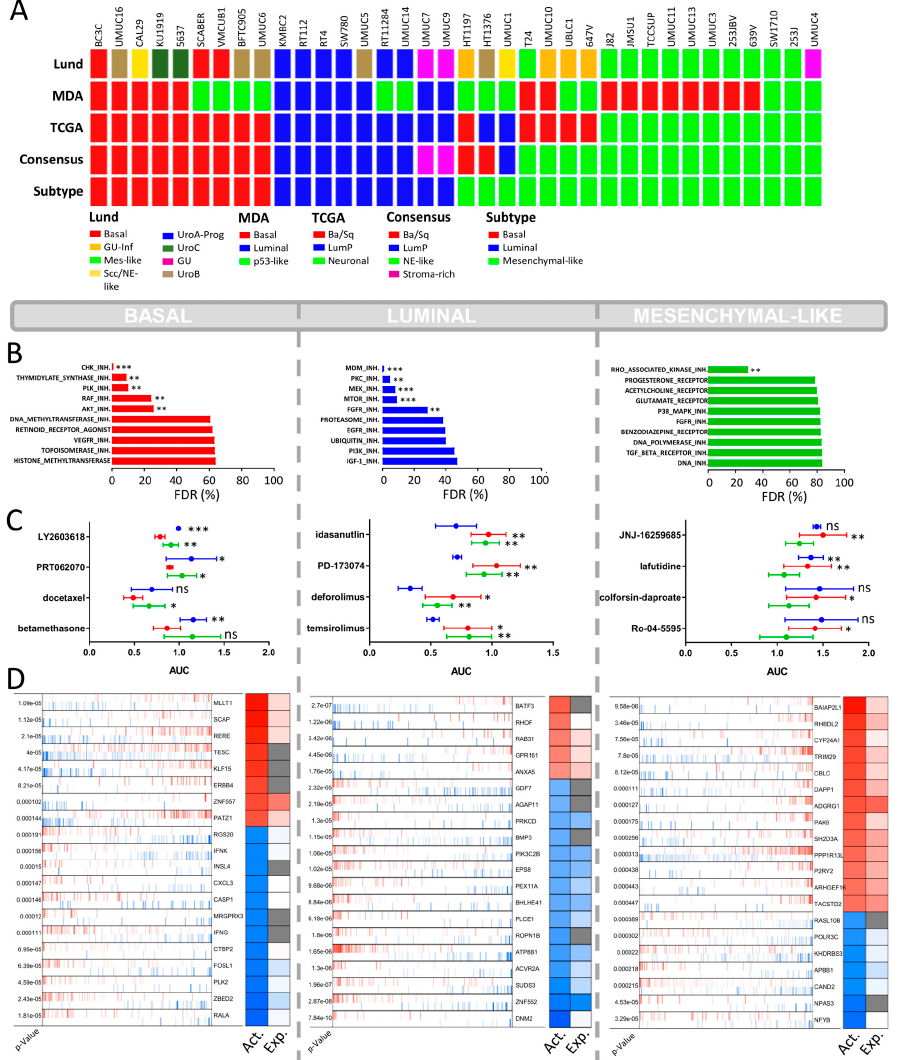
Figure 1. CCLE cell lines high-content drug screen. ( A ) Subclassification of the CCLE cell lines ( n = 36) into the main known molecular BLCA subtype taxonomies: MDA, LUND, TCGA, and Consensus subtypes. The known subtypes converge into 3 main overlapping subtypes (“Subtype”): basal, luminal, and mesenchymal-like. Scc/NE-like = squamous cell carcinoma/neuroendocrine-like, GU-inf = genomical unstable infiltrated, UroA-Prog = Urobasal A progression, Mes-like = mesenchymal-like, LumP = luminal papillary, Ba/Sq = basal/squamous. ( B ) Drug set enrichment analysis based on the AUC values of the PRISM Repurposing dataset. A total of 1448 drugs were classified into 77 specific drug sets (e.g., MTOR inhibitors. PI3K inhibitors). FDR = false discovery rate. ( p < 0.002: **, p < 0.001: ***) ( C ) Top 4 hits with the highest differential growth inhibition between the basal, luminal, and mesenchymal-like BLCA subtypes. NS = non-significant ( p < 0.033: *, p < 0.002: **, p < 0.001: ***) ( D ) Virtual inference of protein-activity by enriched regulon analysis (VIPER) displaying differential regulon activity (first column: red = activated; blue = inactivated) and regulon expression (second column: red = high expression; blue = low expression; gray = not applicable) between subtypes. Representation of the top 20 most significantly activated or inactivated